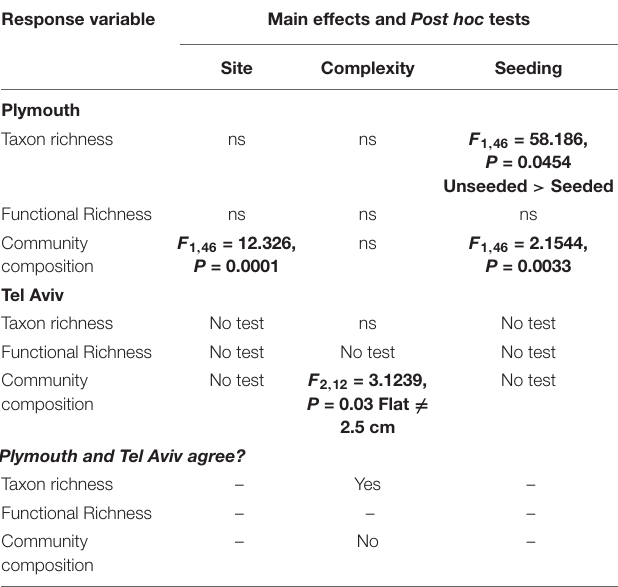
TABLE 3 | Summary of PERMANOVA test results comparing richness (taxon and functional) and community composition from Plymouth, United Kingdom (NE Atlantic) and Tel Aviv, Israel (eastern Mediterranean Sea) and how results compared across